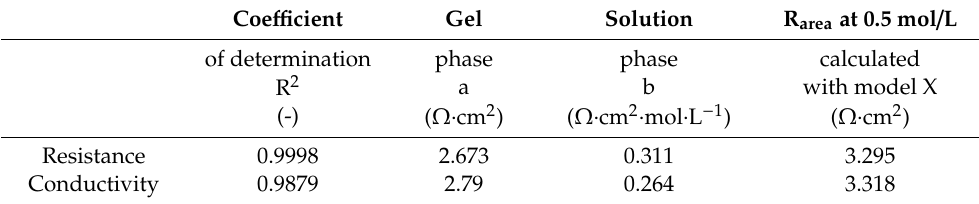
Figure 8. Fit of model X (one thread model) for a CMX membrane. ( a ) Resistance vs. concentration, ( b ) Conductivity vs. concentration. Experimental data from [1]. Table 6. Results of the resistance and conductivity fit of the 1-thread model of a CMX